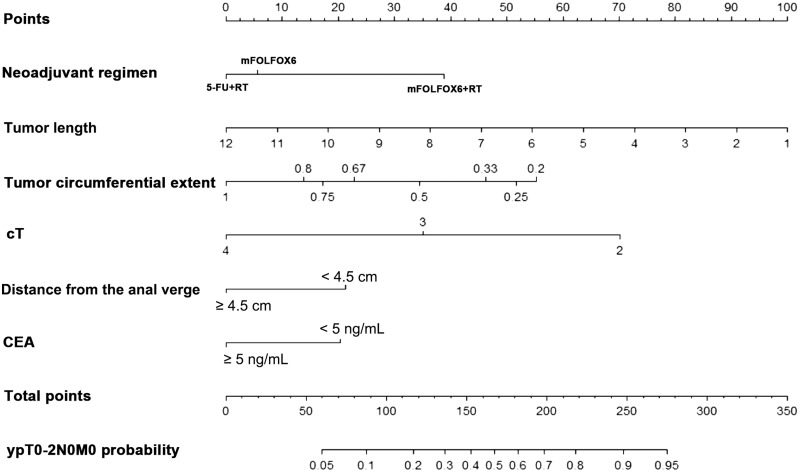
Nomogram for good response prediction. A score for each predictor can be read out at the top scale (score). All summed scores can be converted directly to the probability of response.